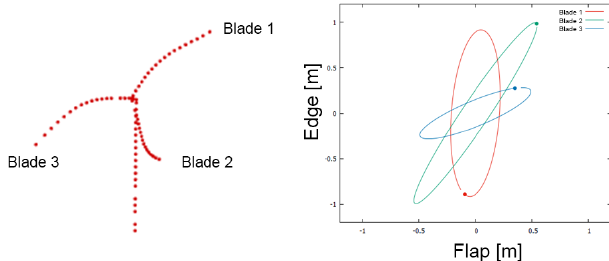
Figure 27. Shape of the lowest damped M7 mode at the azimuth angle 20 ◦ . Trace of the modal displacement of the three